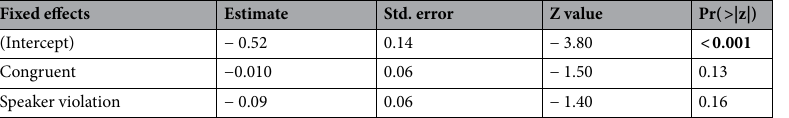
Table 9. Summary of Frequentist Logistic Linear Mixed Effects Model for Experiment 2 with full violation as the reference level. Significant values are in